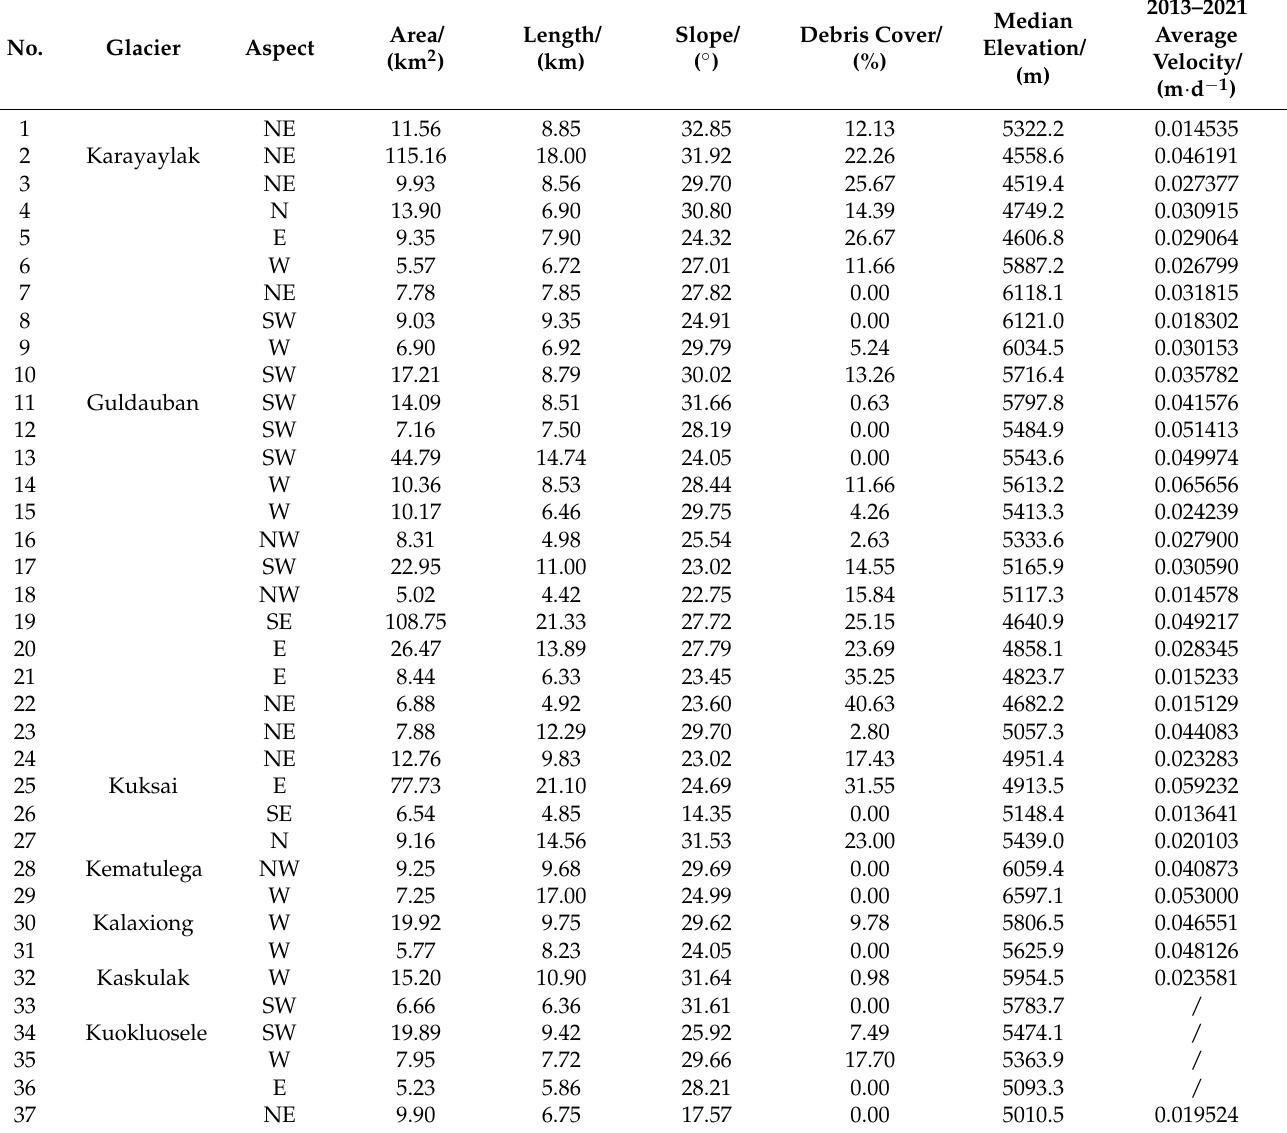
Table 2. Parameters of glaciers larger than 5 km 2 in the Muztag-Kongur